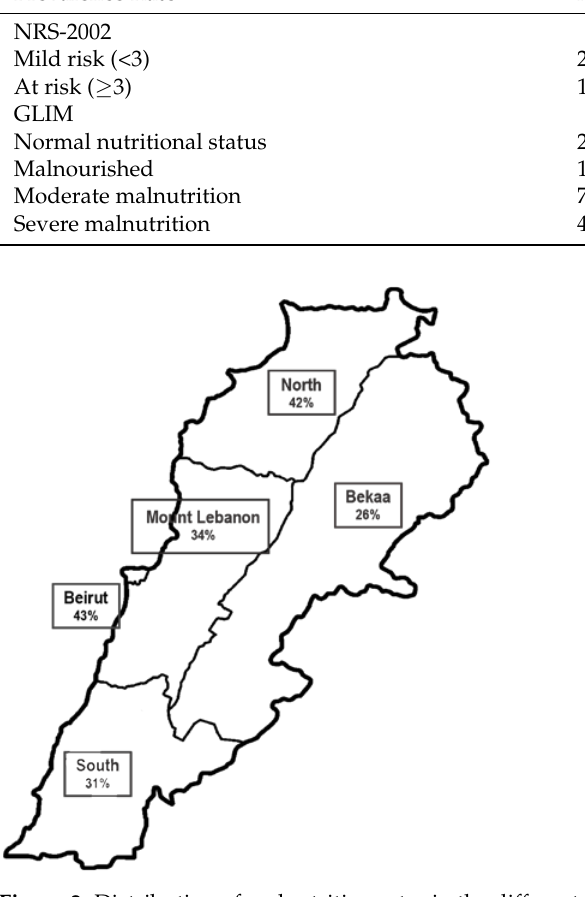
Figure 2. Distribution of malnutrition rates in the different districts according to Global Leadership Initiative on Malnutrition (GLIM).